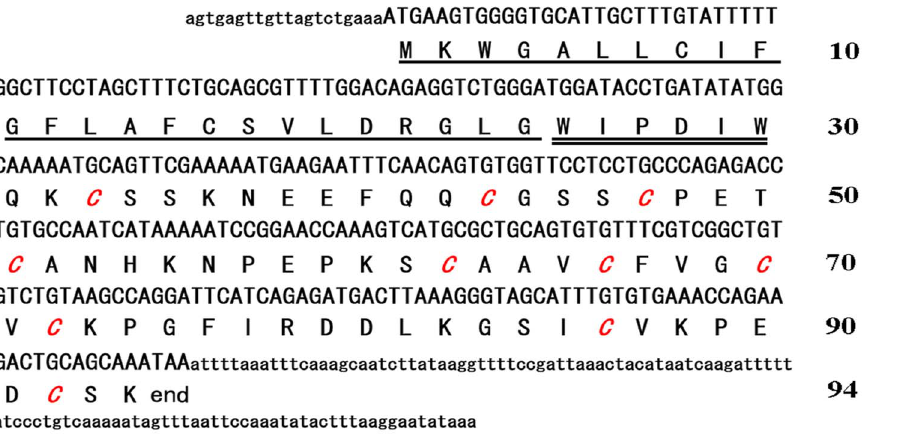
Figure 2. Precursor nucleotide sequence and deduced amino acid sequence of Ascaris -type toxin SjAPI. The signal peptide, propeptide, and mature peptide were marked and the cysteine residues of the mature peptide were shown in italics.